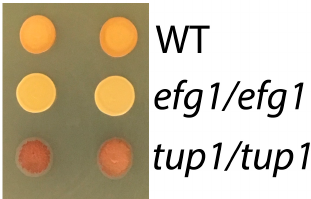
Figure 3. Glycogen content of efg1 / efg1 and tup1 / tup1 mutants from Homan et al. library assessed with the iodine vapor method. Ten microliters of a stationary culture were grown for 6 h on YPD plates and exposed to iodine vapor for 15 min (in duplicate). The intensity of brown coloration is a measure of glycogen content ( efg1/efg1: low; tup1/tup1: high).